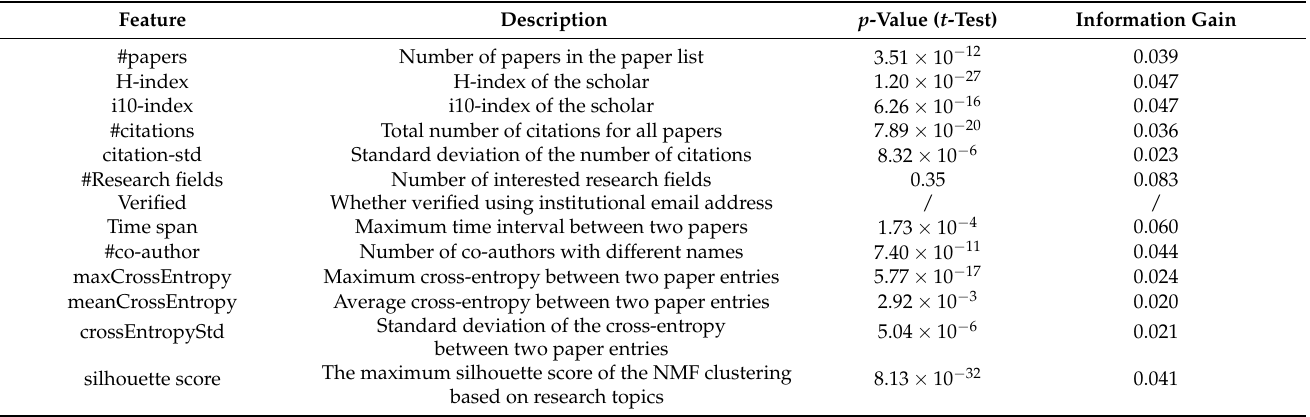
Table 1. Feature